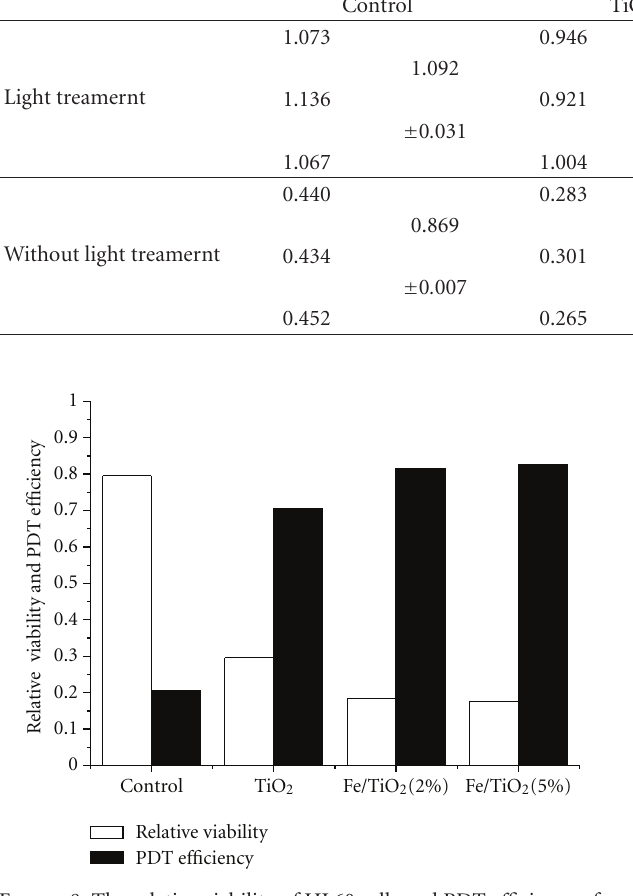
Figure 8: The relative viability of HL60 cells and PDT e ffi ciency of di ff erent nanopariticles.